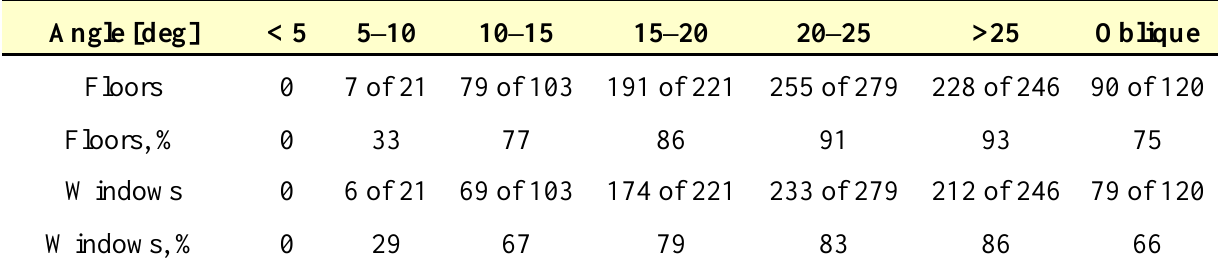
Table 3. Correct number of floors (above) and number of windows (below) from vertical images versus look angles. Right shows oblique result: Floor counts are compromised by